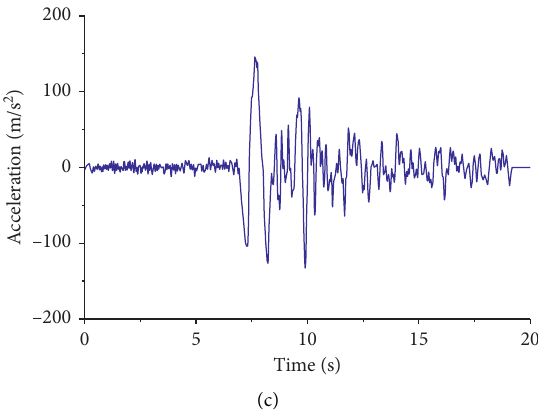
Figure 7: Acceleration time history curves of earthquakes. (a) El-Centro record. (b) Taft record. (c) Ninghe